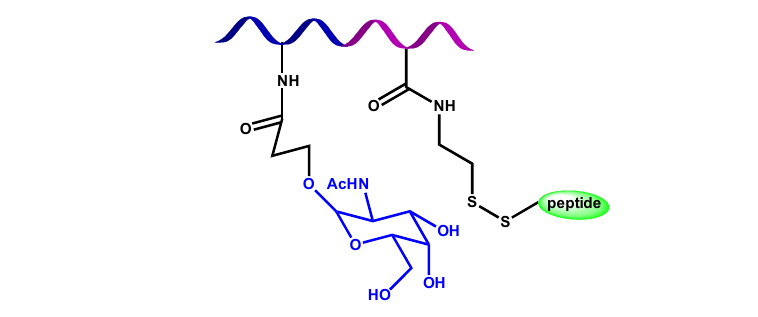
Figure 10. Glycopolymer vaccine structure.